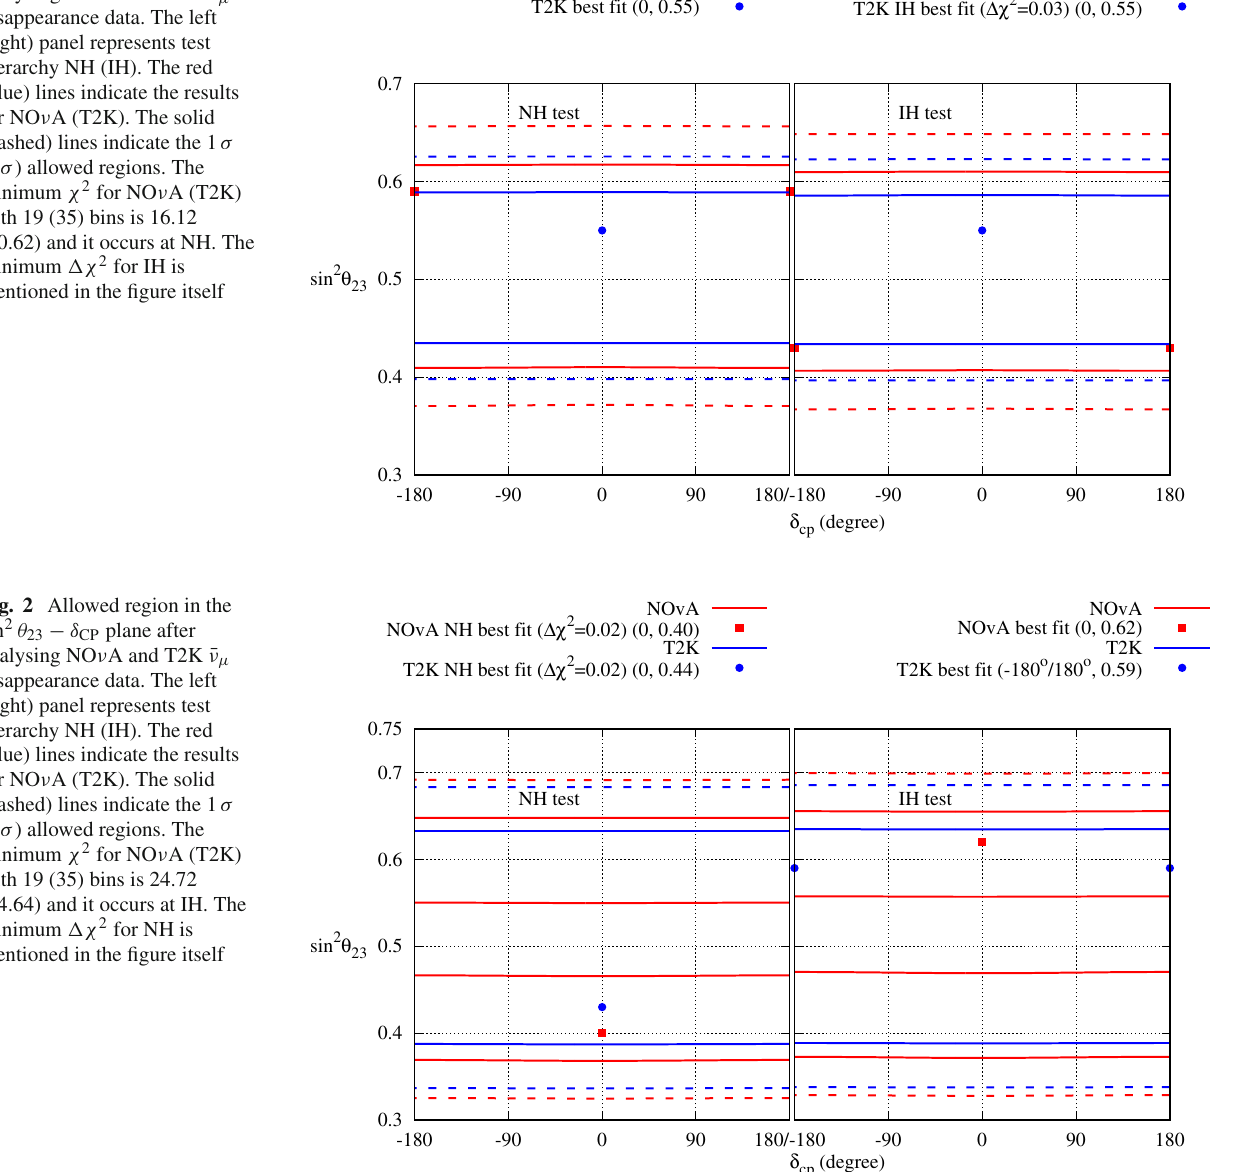
Fig. 1 Allowed region in the sin 2 θ 23 − δ CP plane after analysing NO ν A and T2K ν μ disappearance data. The left (right) panel represents test hierarchy NH (IH). The red (blue) lines indicate the results for NO ν A (T2K). The solid (dashed) lines indicate the 1 σ (3 σ ) allowed regions. The minimum χ 2 for NO ν A (T2K) with 19 (35) bins is 16.12 (40.62) and it occurs at NH. The